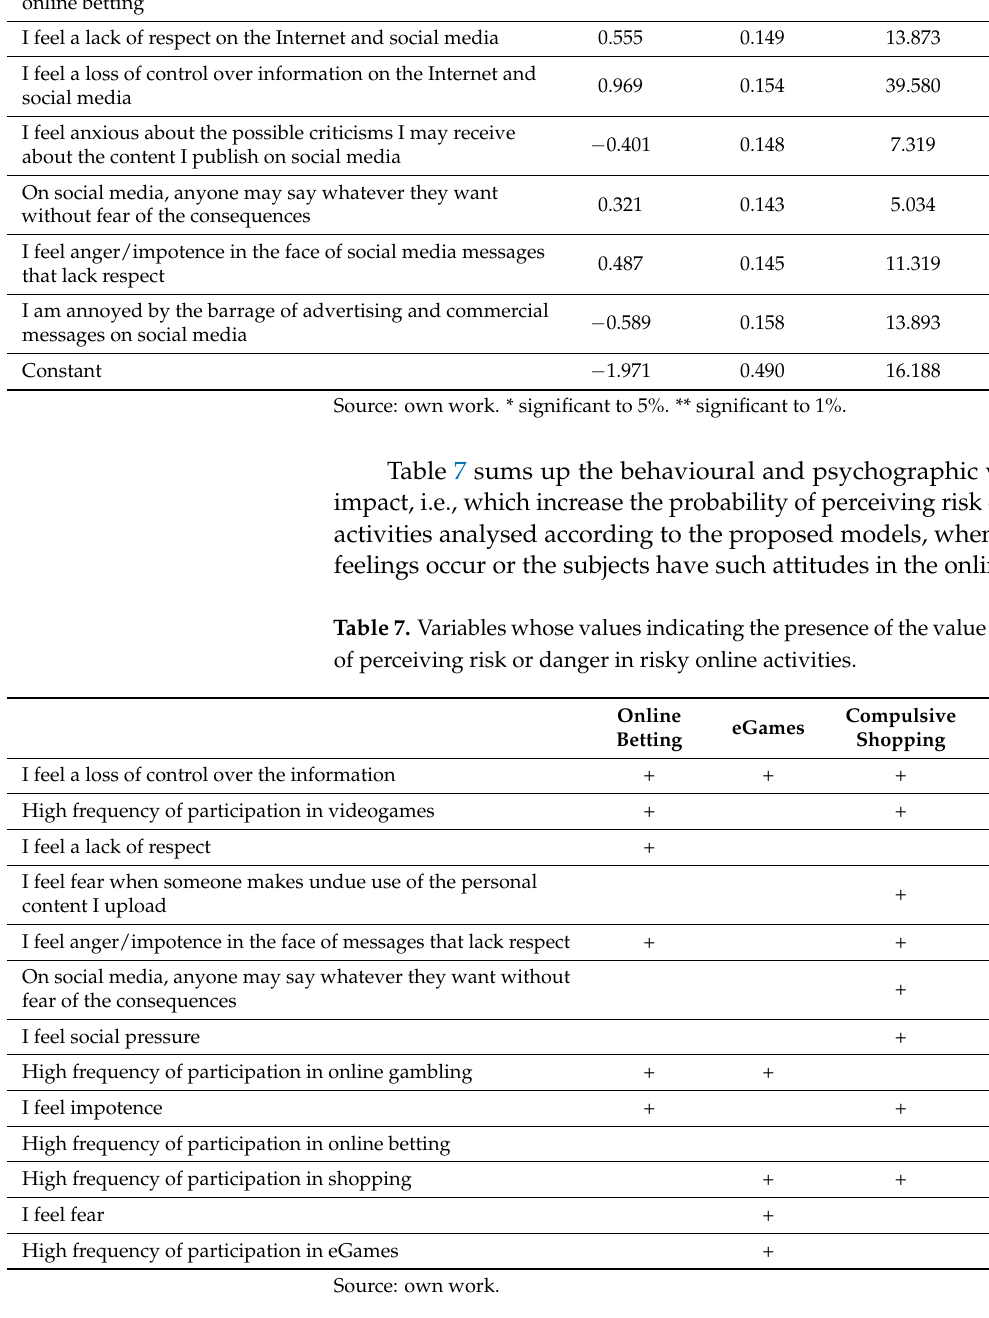
Table 8 sums up the psychographic variables that have a negative impact, i.e., which reduce the probability of perceiving risk or danger in each of the online activities